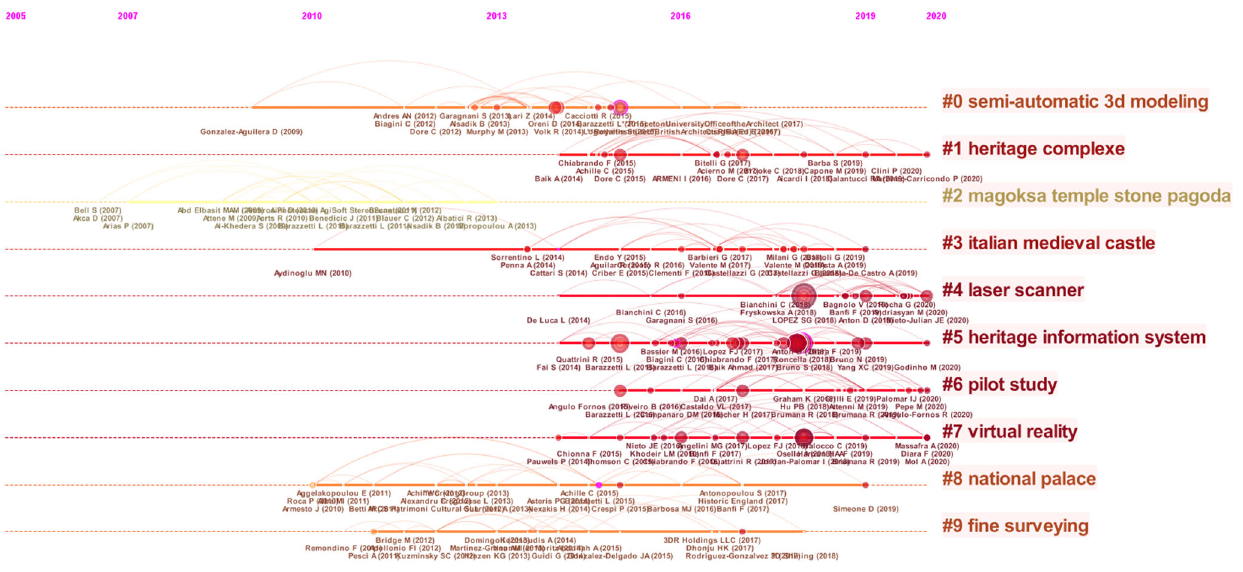
Fig. 9 Clustered timeline view of literature co-citations. Clustered view of literature co-citations analyzed by CiteSpace bibliometric analysis